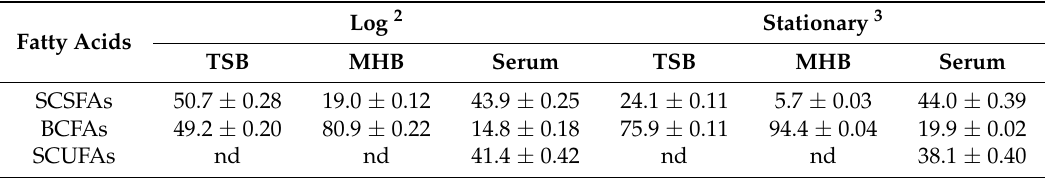
Table 1. Fatty acid composition (%) 1 of strain Pig1 grown in various media.